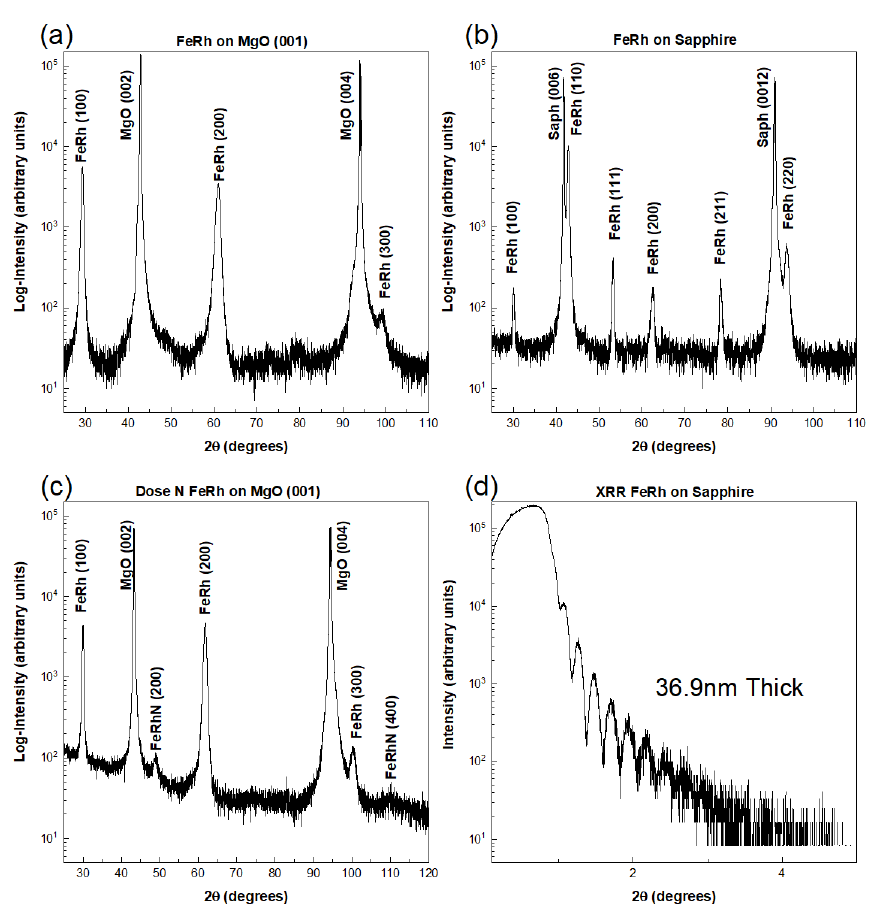
Figure 1. XRD data from FeRh thin film samples. ( a ) XRD theta-2theta curve of FeRh on MgO. ( b ) XRD theta-2theta curve of FeRh on Sapphire. ( c ) XRD theta-2theta curve of FeRh on MgO after dosing with N + . ( d ) X-ray reflectivity curve showing interference fringes for FeRh on sapphire sample with thickness of 36.9 nm.